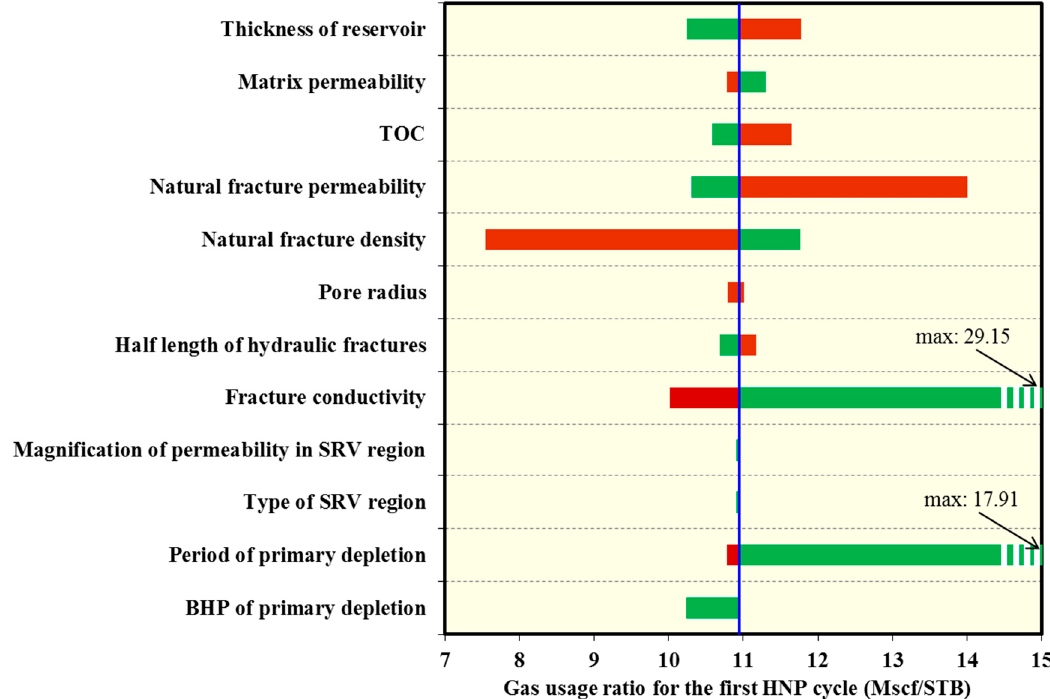
Figure 32. Tornado chart indicating the most and least sensitive parameters for gas usage ratio. Each green bar corresponds to a sensitivity measure (compared to a base case) when a parameter is set to its lower bound. The red bars are for the upper bounds. The vertical blue line denotes the base case.